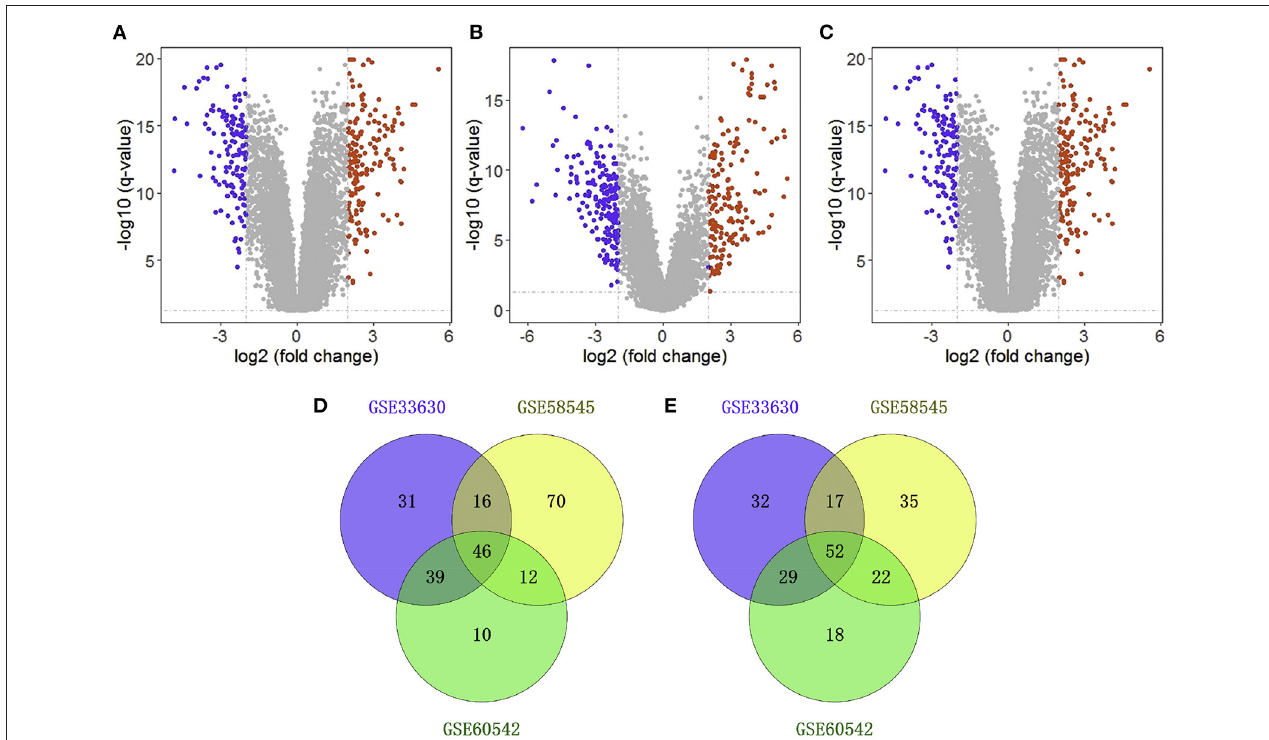
FIGURE 1 | Identification of differentially expressed genes (DEGs). Volcano plot showing the differentially expressed genes of GSE33630 (A) , GSE58545 (B) , and GSE60542 (C) . Veen diagram of downregulated (D) and upregulated (E) common DEGs to three gene expression profiles.